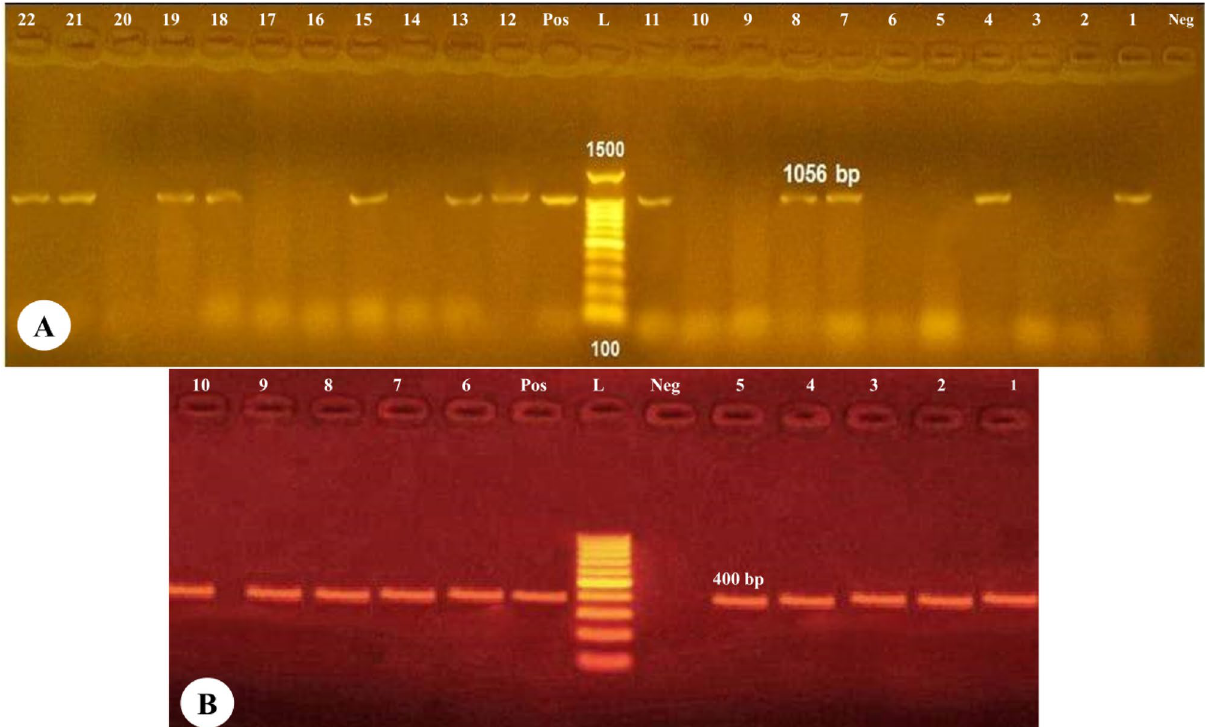
Figure 1. Agarose gel electrophoresis for the products of PCR fingerprinting of ( A ) Cryptosporidium spp. and ( B ) C. parvum . Lane (L): DNA marker ladder; Lane Pos: positive control and Lane Neg: negative